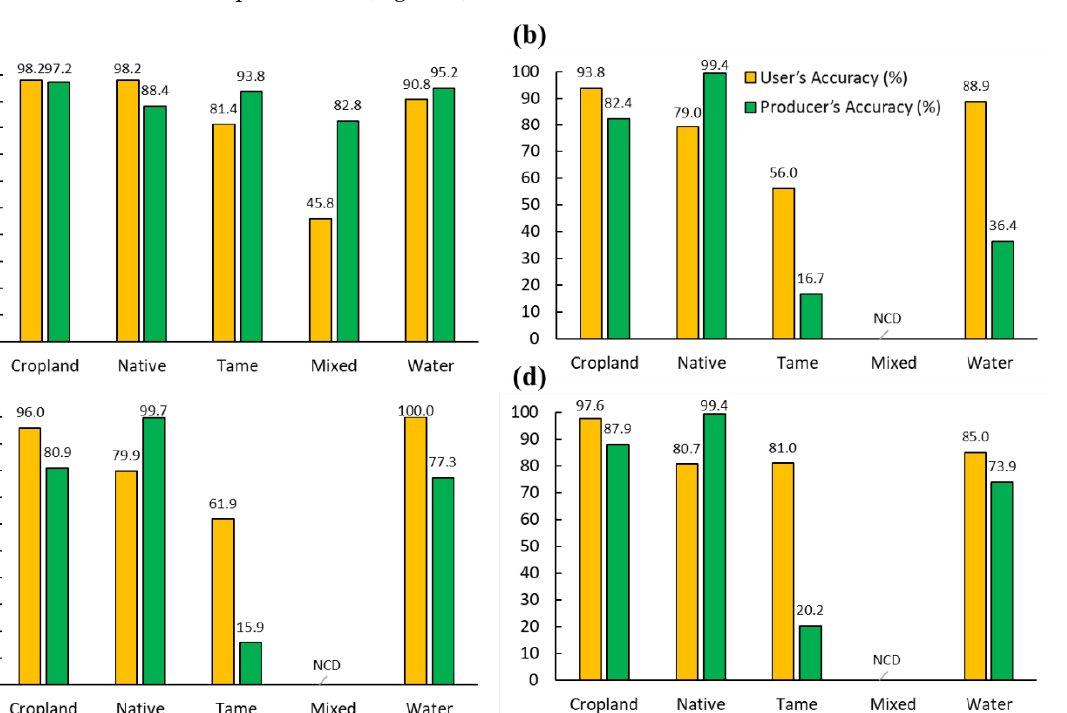
Figure 6. Quantification of the accuracy assessment depending on local ecologists using a spatial survey web portal (PLI Review Web Application) to calculate opinion of MGE classification. 4.2. Grassland Spatial Distribution Native grassland occupies 33.9% (about 2.9 million hectares) of the MGE total area (8.63 million ha). Croplands are the dominant land cover class in the MGE, which covers 52.2% (4.5 million ha; Figure 7a). Tame grassland covered approximately 2.3% (about 0.2 million ha), and mixed grassland is 4% (0.34 million ha). It should be noted that this ecore- gion likely has one of the highest proportions of native grassland remaining in